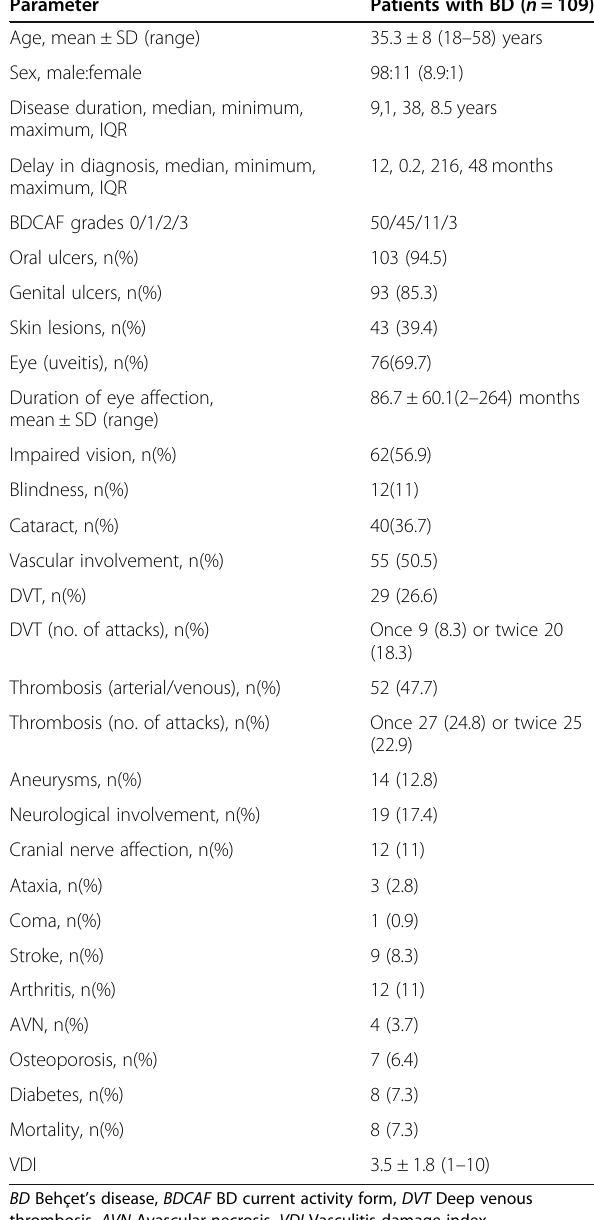
Table 1 Demographic and clinical data of patients with BD Parameter Patients with BD ( n = 109)